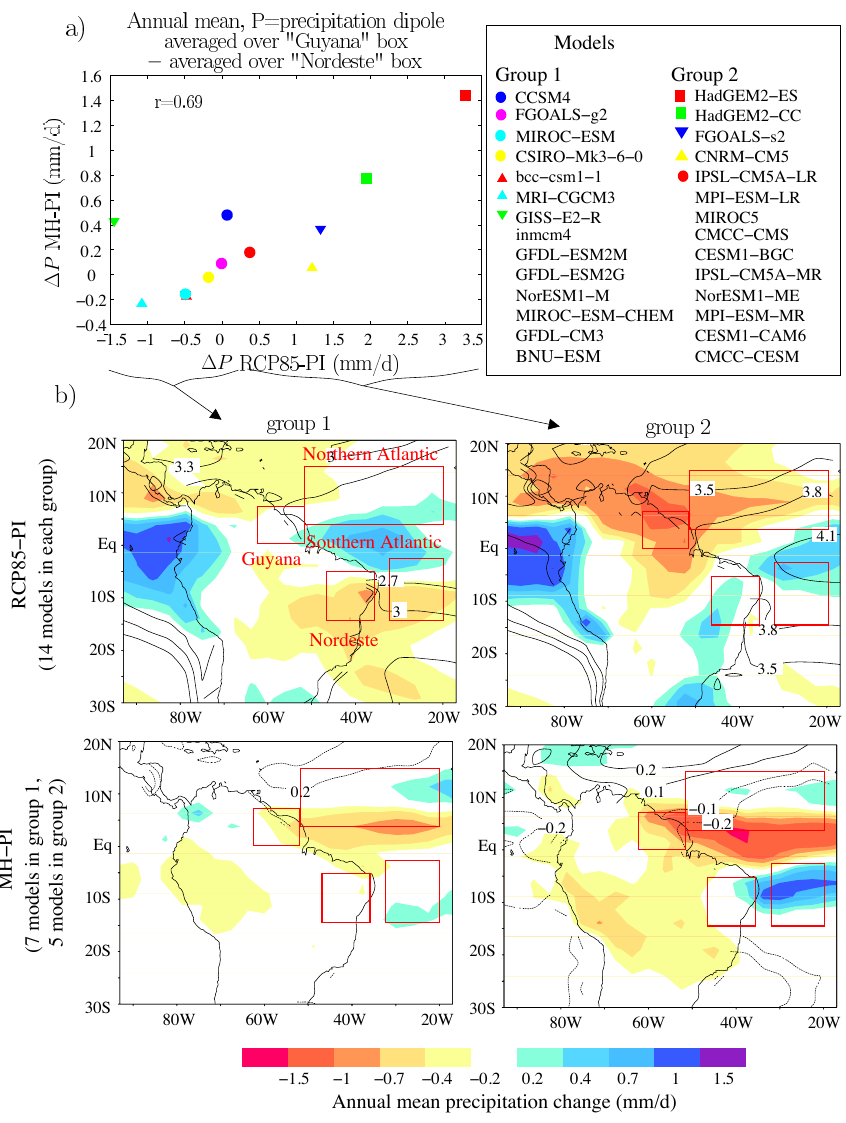
Fig. 3. (a) Relationship between the precipitation dipole change from pre-industrial to future climate under RCP 8.5 for the 2080–2100 and the precipitation dipole change from pre-industrial to mid-Holocene. The precipitation dipole is defined as the difference of precipitation change in RCP 8.5 between the “Guyana” region and the “Nordeste” region. Only those models within each group that had both rcp85 and midHolocene data available at the time of the analysis are plotted. Other models that provided only rcp85 data are listed for completeness, but without any markers. (b) Maps of precipitation changes from piControl to rcp85 (top panels) and from piControl to midHolocene (bottom panels) in average over all available models in group 1 (left panels) and in group 2 (right panels). Contours show corresponding SST changes. The boxes over land and ocean show the areas used in the dipole